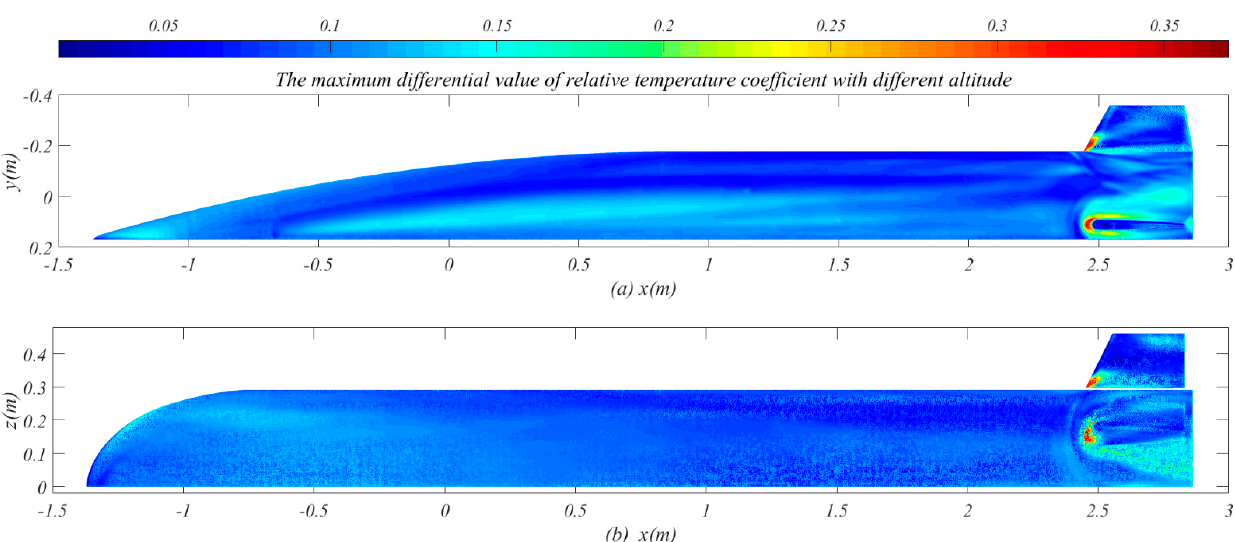
Figure 12. The maximum differential value of relative temperature coefficient with different Mach number: ( a ) the side view of aircraft; ( b ) the top view of aircraft. When the flight angle of attack changes, the shock angle changes, which makes the aerodynamic heating area and position change. In Figure 10a, the rear side of the leeward surface is in an area where the shock wave flows around and is far away from the position where the shock wave is generated, so changing the angle of attack has little effect on its wall temperature distribution. However, in Figure 10b, the leeward surface, especially the wedge-shaped region, is close to the head cone shock wave, and the angle of attack has a great influence on it, so the angle of attack has a great influence on the temperature dis- tribution in this area. When the flight altitude increases, the pressure of the flow field decreases greatly, while the temperature of the incoming air increases gradually; when the Mach number increases, the velocity of incoming flow increases. These flight conditions affect the flow